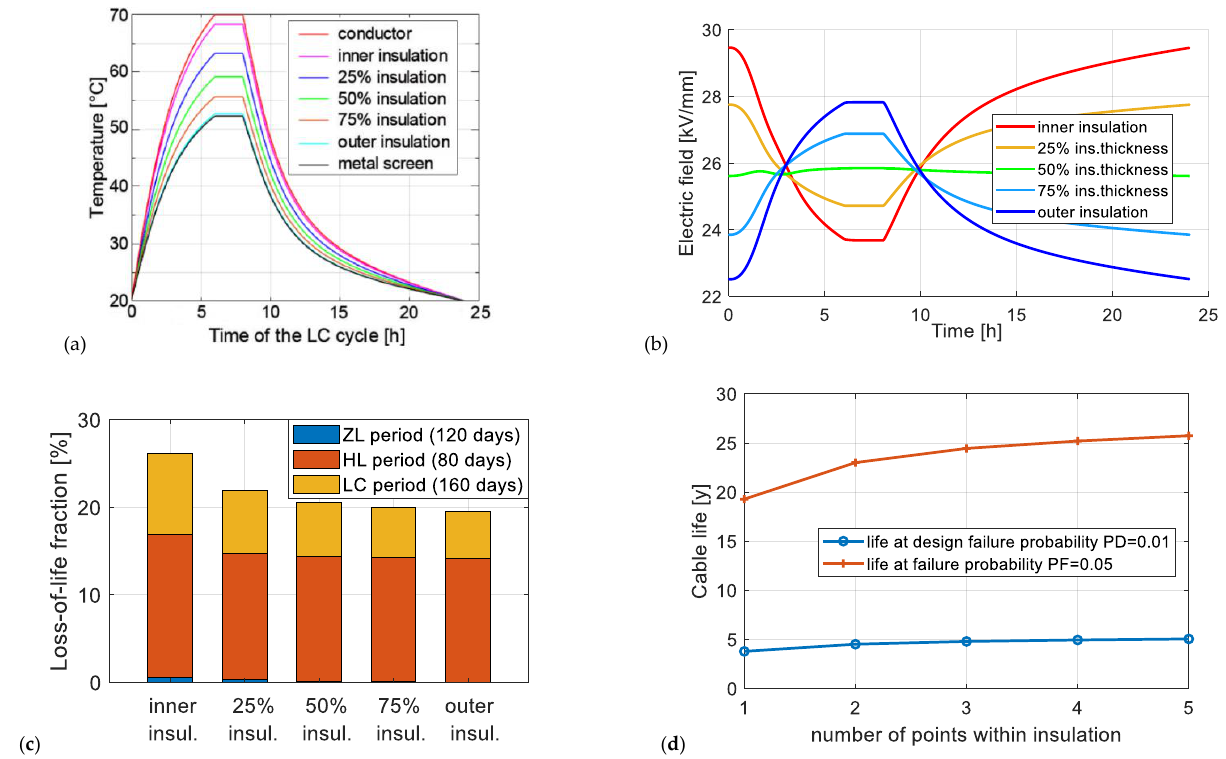
Figure 5. ( a ) Transient temperature profiles during 24-h load cycles (LCs), ( b ) transient field profiles during 24-h LCs, ( c ) loss-of-life fractions in the LC, HL, ZL periods, and in the whole 360 days of the prequalification test (PQT), ( d ) time-to-failure percentiles at 1% and 5% failure probability for a 500 kV DC-XLPE cable with 2000 mm 2 cross section copper conductor under VSC PQT conditions. Conductivity coefficients a = 0.085 K − 1 , b = 0.0645 mm/kV.